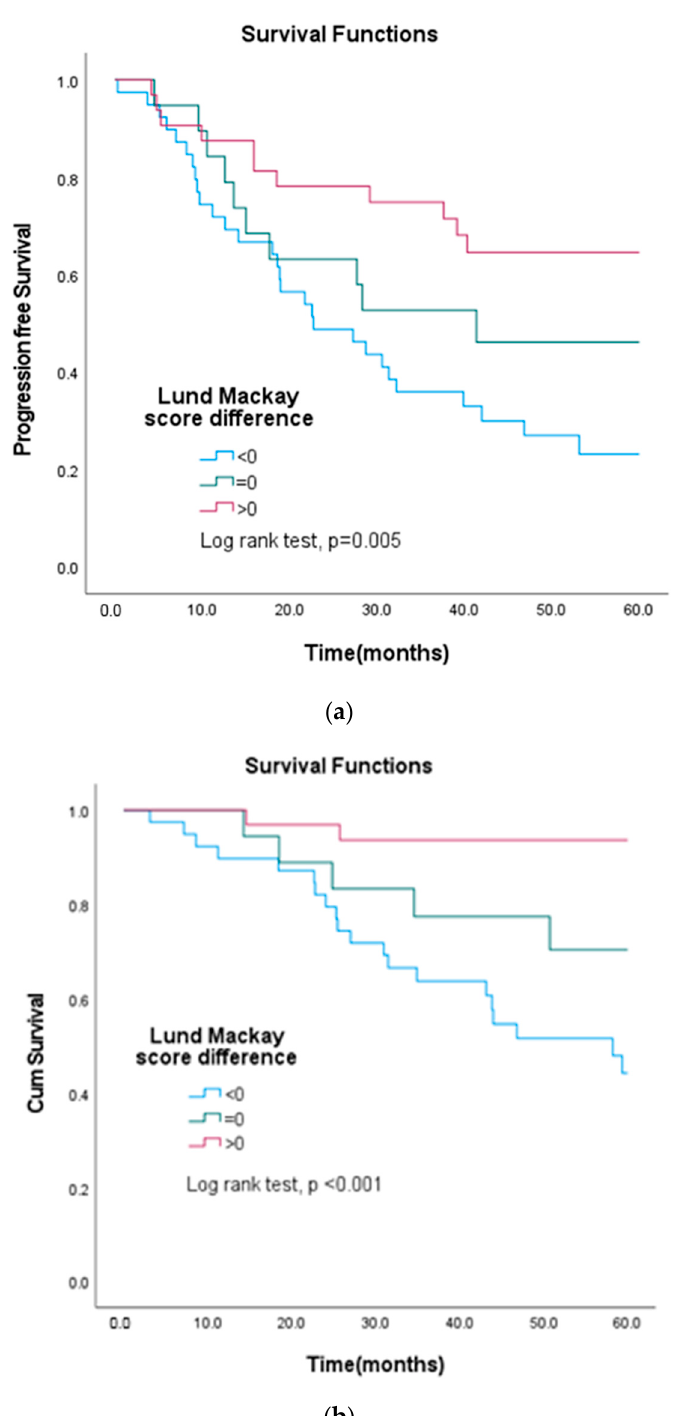
Figure 1. ( a ) The log ‐ rank test of L – M scores difference <0 had the worst progression ‐ free survival (PFS) compared to L – M score difference > 0 ( p < 0.001). ( b ) The log ‐ rank test of L – M scores (PFS) compared to L–M score difference > 0 ( p < 0.001). ( b ) The log-rank test of L–M scores difference <0 had the worst overall survival compared to L – M score difference > 0 ( p < 0.001).